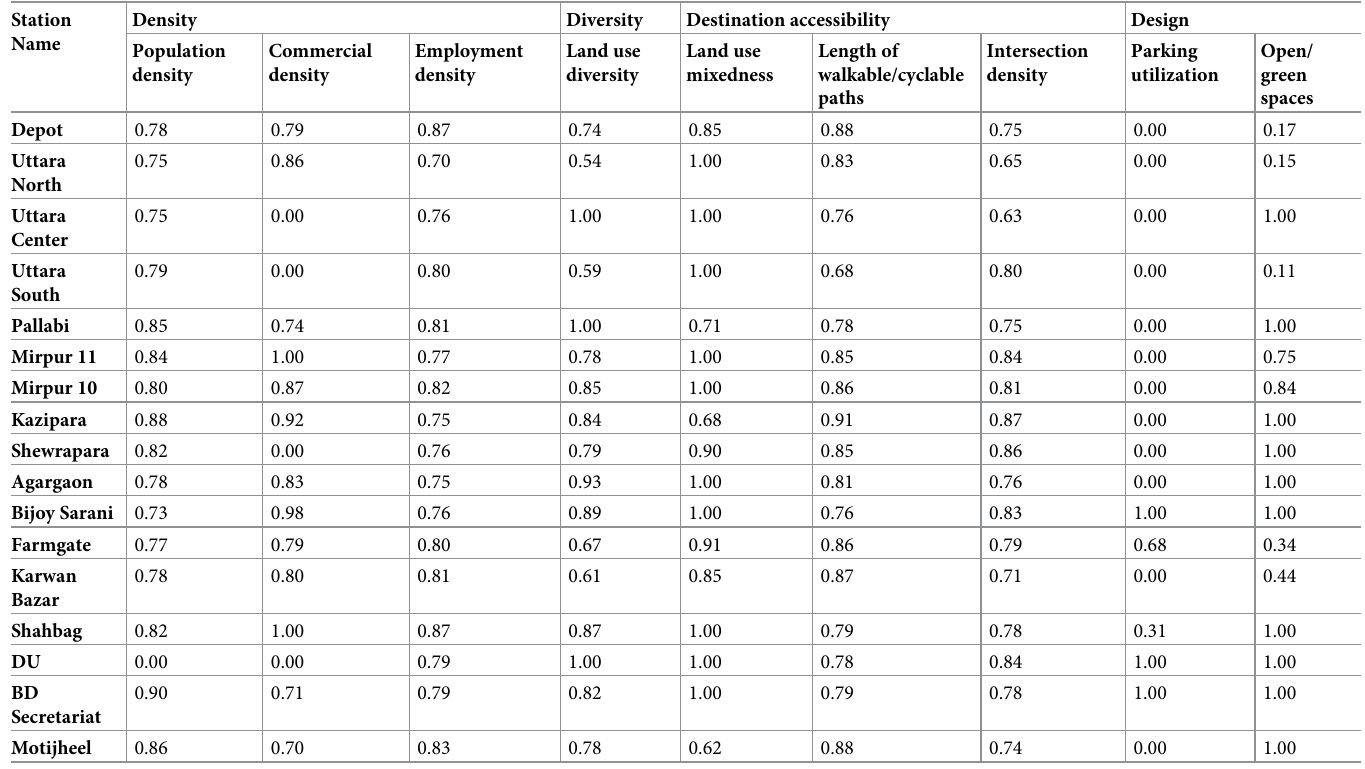
Table 3. Criteria and indicators’ standardized values for 17 stations’ buffers.